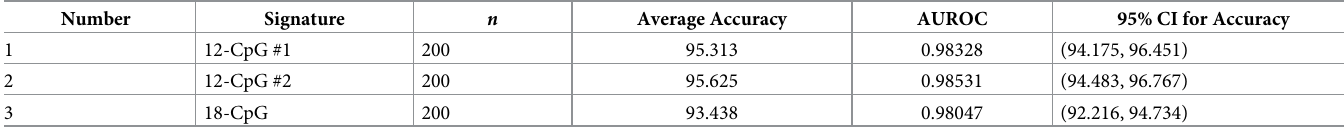
Table 6. Average hidden data accuracy across a large number of dataset